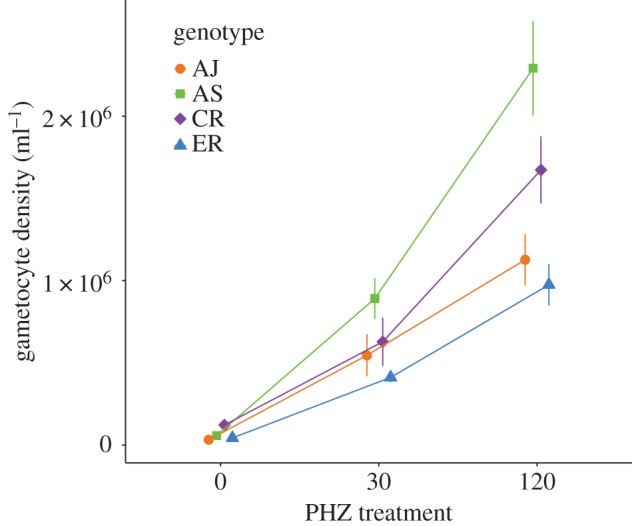
Reaction norms for conversion rate (mean ± SE gametocyte density for days 2 and 3 PI) of four genotypes across PHZ treatments (left to right along x-axis represents a decrease in total red blood cell density and an increase in reticulocyte proportion). All genotypes increase their conversion as PHZ dose increases, but to different extents (note, there is no significant difference between AJ and ER). The points are dodged horizontally for clarity. (Online version in colour.)